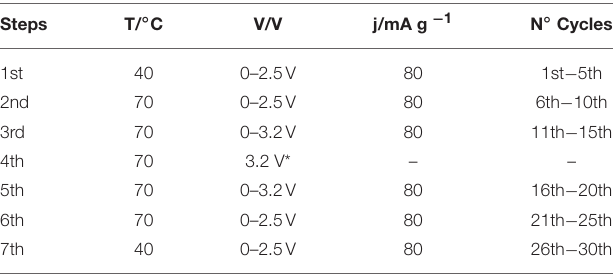
TABLE 2 | Electrochemical conditions and temperature during the durability test.